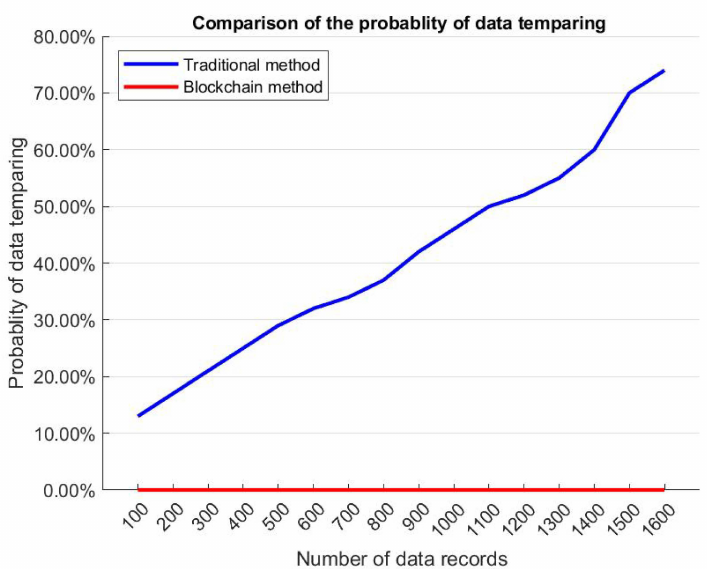
Figure 13. The probability of data manipulation is compared.